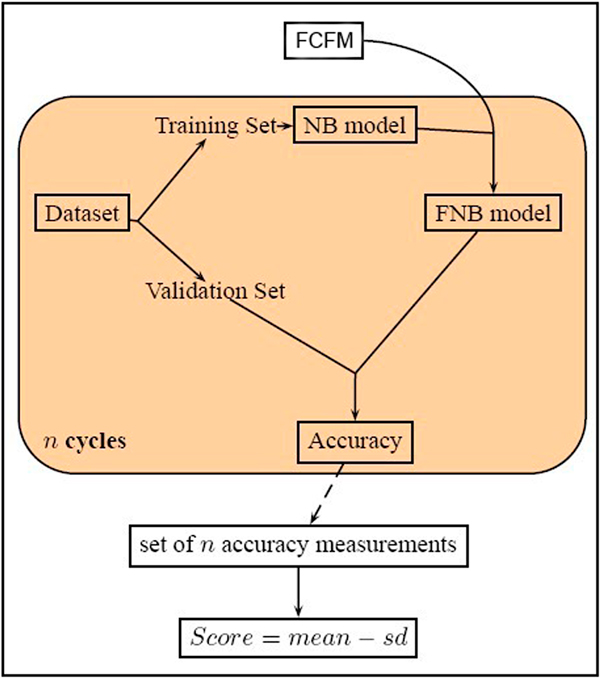
Computation of Fitness score. Steps of calculating Fitness score.